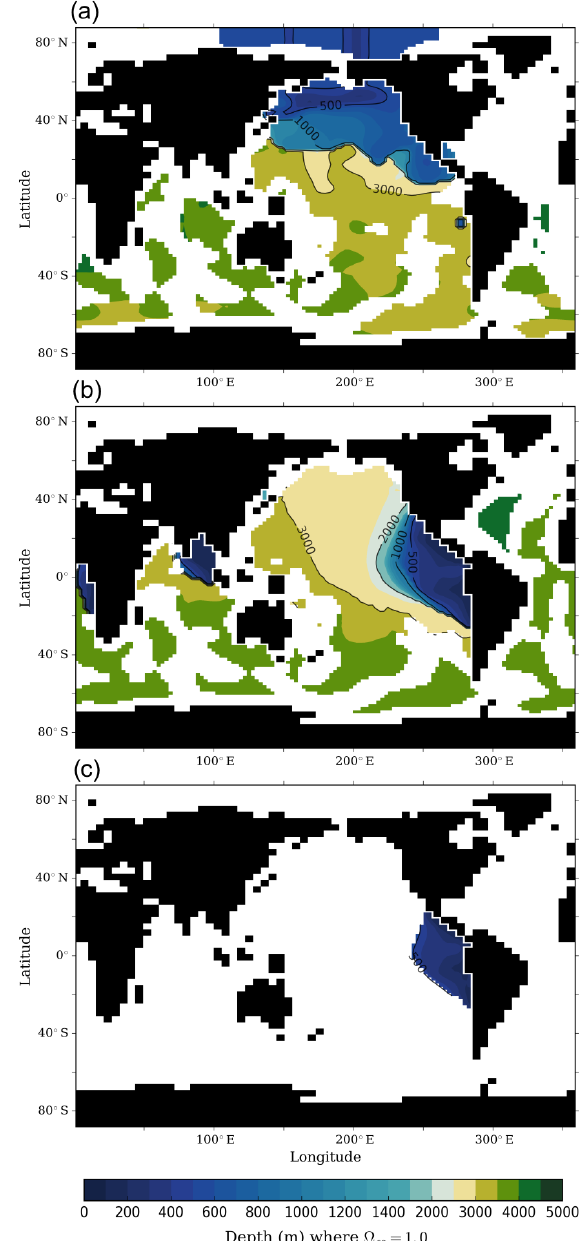
Figure 8. The depth at which calcite becomes undersaturated in the water column (where (cid:127) ca = 1) calculated from (a) the observa- tions of Key et al. (2004) (global mean calcite saturation horizon: 2610m), (b) the O-PI experiment (global mean calcite saturation horizon: 2666m) and (c) the O-LGM experiment (global mean cal- cite saturation horizon: 3208m). The contour lines represent 500, 1000, 2000 and 3000m depth. Note that the O-LGM experiment, which is unmodified in its biogeochemistry relative to the O-PI ex- periment, is completely saturated for calcite across the majority of the ocean (white